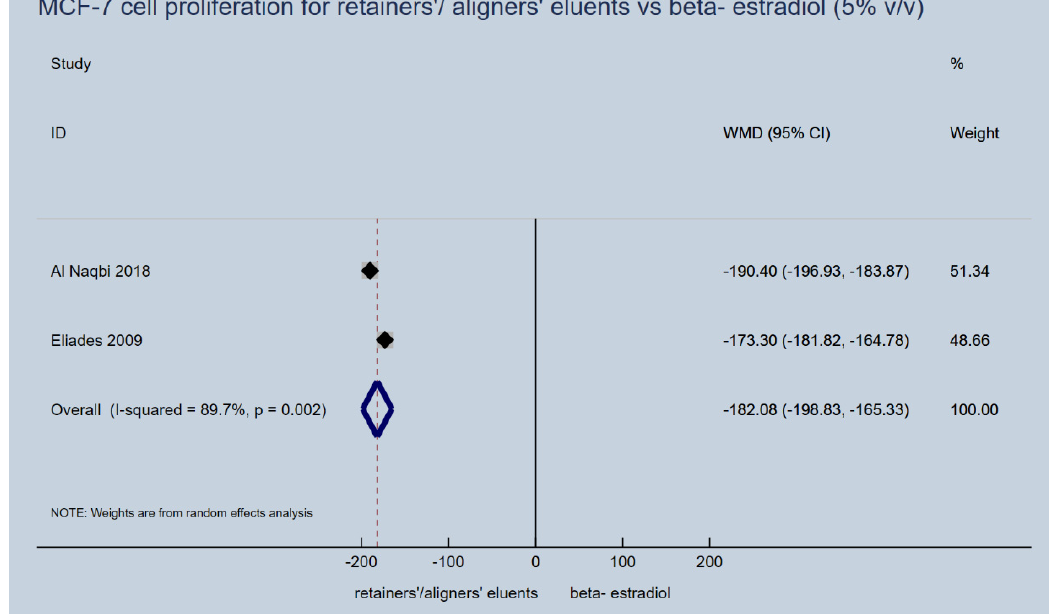
Figure 3. Random effects meta-analysis on the effect of thermoplastic appliances’ eluents versus beta- Figure 3. Random e ff ects meta-analysis on the e ff ect of thermoplastic appliances’ eluents versus estradiol (5% v/v) to induce proliferation activity of MCF-7 cells. beta-estradiol (5% v / v ) to induce proliferation activity of MCF-7